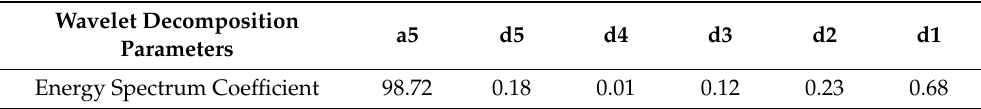
Table 3. Energy spectrum coefficient table of noise signal S2 of Yellow River Bridge. Wavelet Decomposition